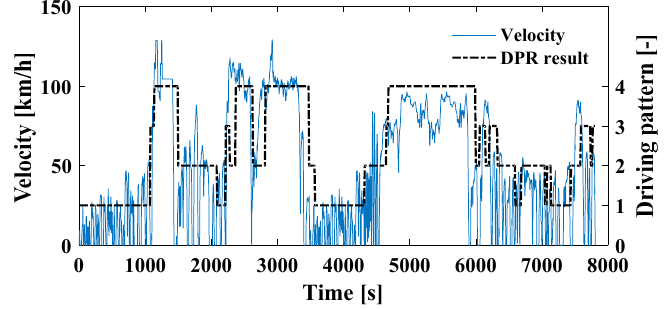
Figure 9. Velocity profile and the DPR result.